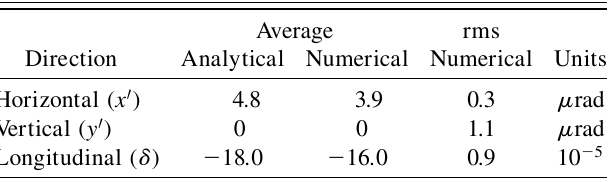
TABLE II. For the LCLS spoiler foil: summary of wake effects in the three directions on target beam particles. The average horizontal force points in the same direction as the head of the